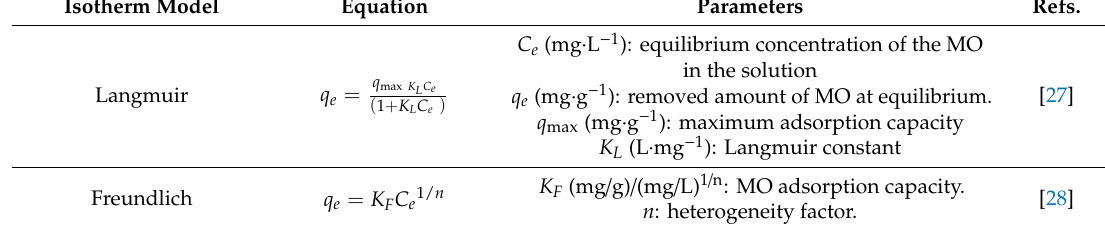
Table 3. Isotherms models used to fit the adsorption of MO on adsorbent Mn–mica. Isotherm Model Equation Parameters